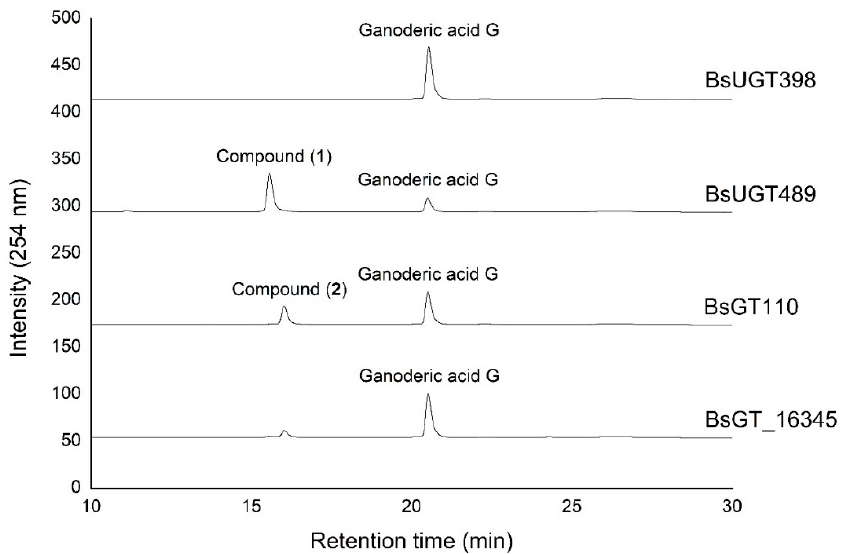
Figure 3. High-performance liquid chromatography (HPLC) results of the biotransformation prod- ucts of GAG using the four Bacillus GT enzymes. The biotransformation and HPLC conditions are described in the Materials and Methods section.